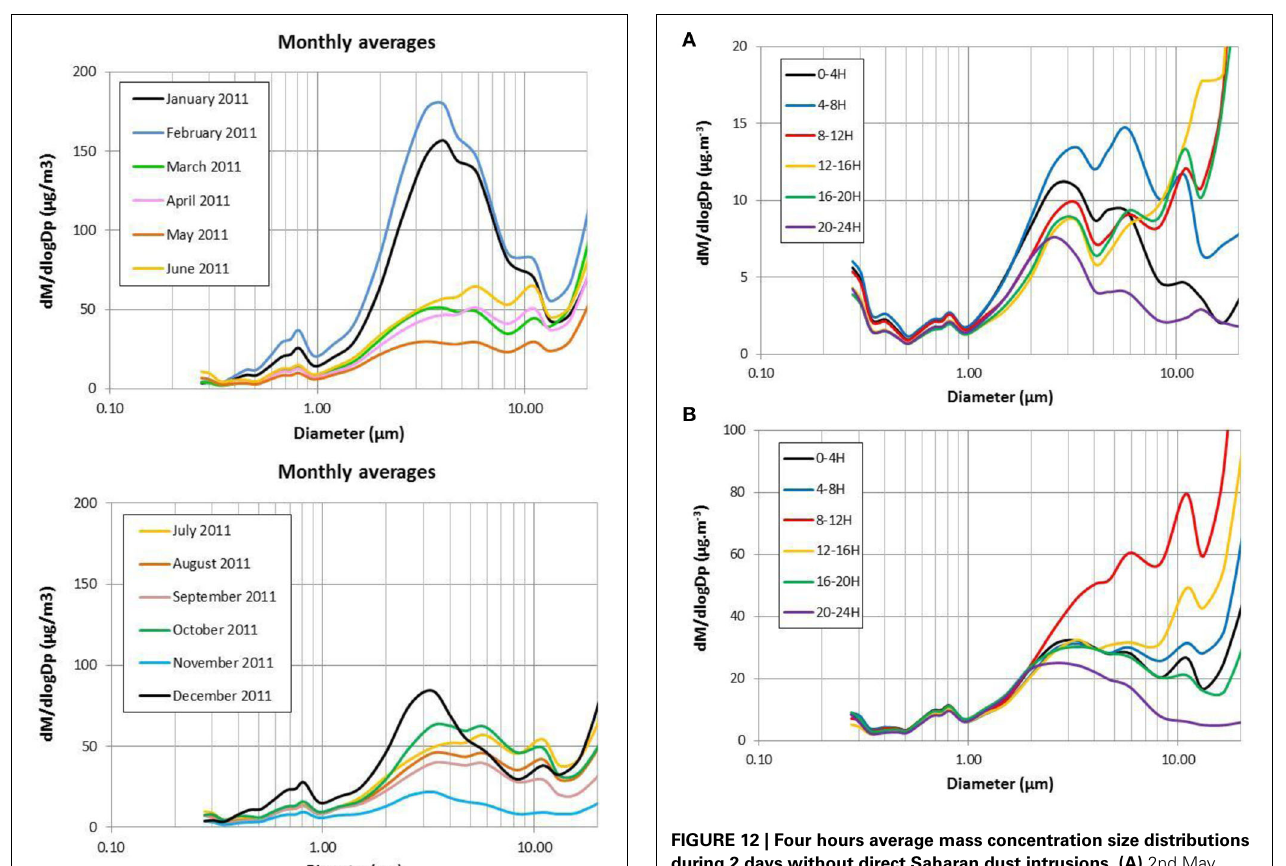
FIGURE 12 | Four hours average mass concentration size distributions during 2 days without direct Saharan dust intrusions. (A) 2nd May, 2011; (B) 12th June,